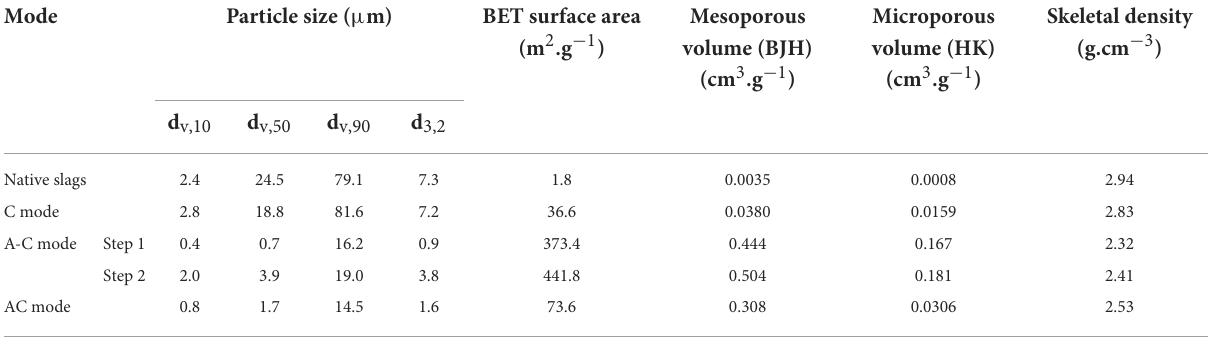
TABLE 2 Textural properties of ferronickel slag feed and carbonation products from C, A-C and AC